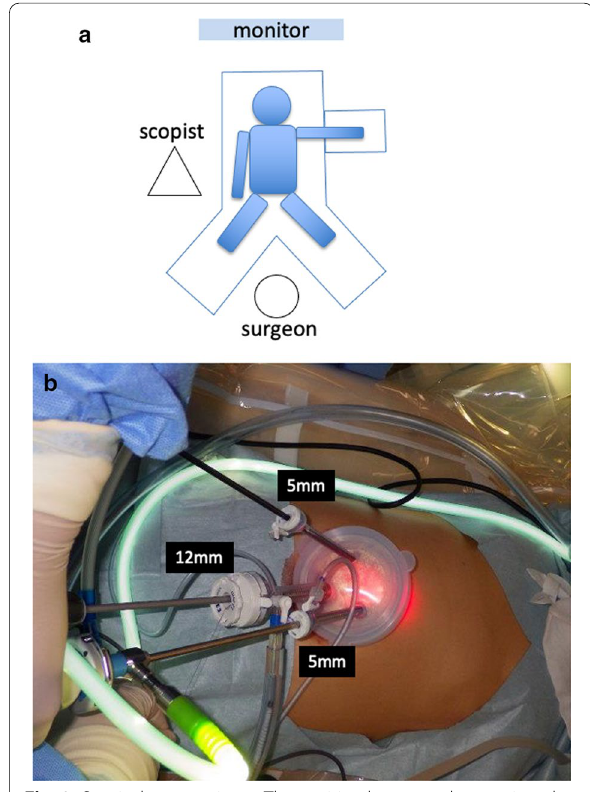
Fig. 2 Surgical port setting. a The position between the monitor, the surgeon and the scopist is shown. b EZ Access equipped with two 5 mm trocars and one 12 mm trocar with an evacuation system for surgical smoke was